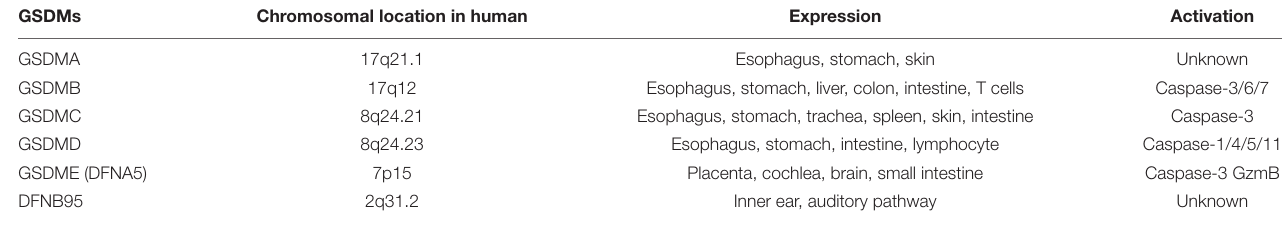
TABLE 1 | GSDM family (Shi et al., 2017; Feng et al.,